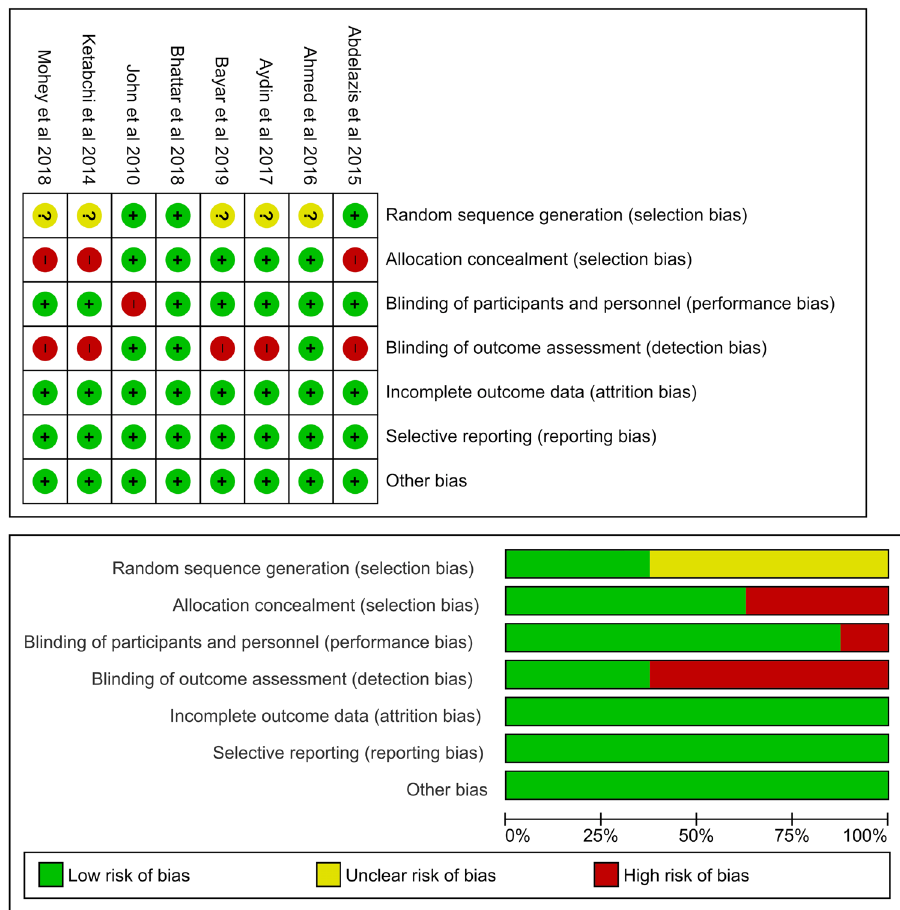
Figure 2. Risk of bias assessment summary using traffic light and summary plots. Selection bias from allocation concealment is present in three studies and not enough information was given to assess random sequence generation. Detection bias was detected in five studies. Only one study presented with performance bias. No attrition or reporting bias were